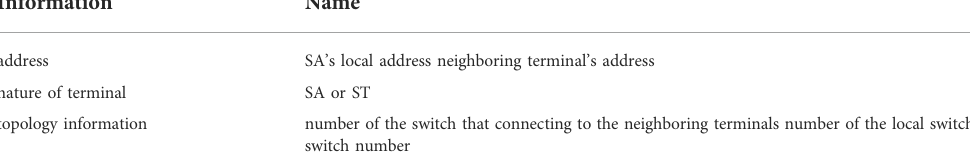
TABLE 1 Basic topology information stored in STU.